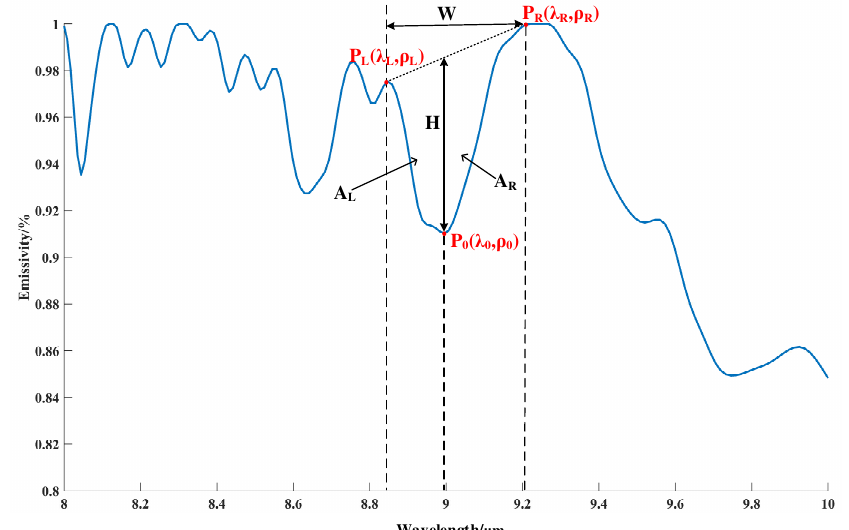
Figure 5. Quantitative parameters of the spectral feature. The red variables indicate the wavelength positions and corresponding emissivity of the emission minimum point (P 0 ), the left and right endpoints (P L and P R ). H is the depth of the emission minima. W is the feature width of the emission minima. A L and A R are the left and right areas of the spectral feature, which can be used to calculate the symmetry of the spectral feature.